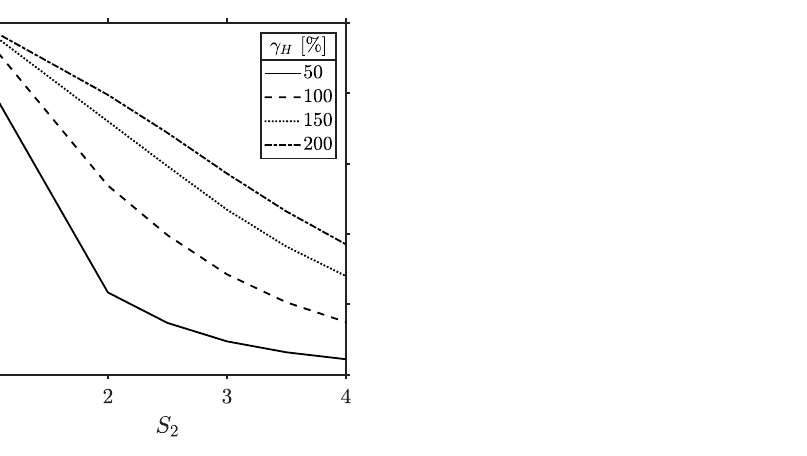
Table 2. Percentage reduction of the  function with the shear strain for different values of the primary shape factor.